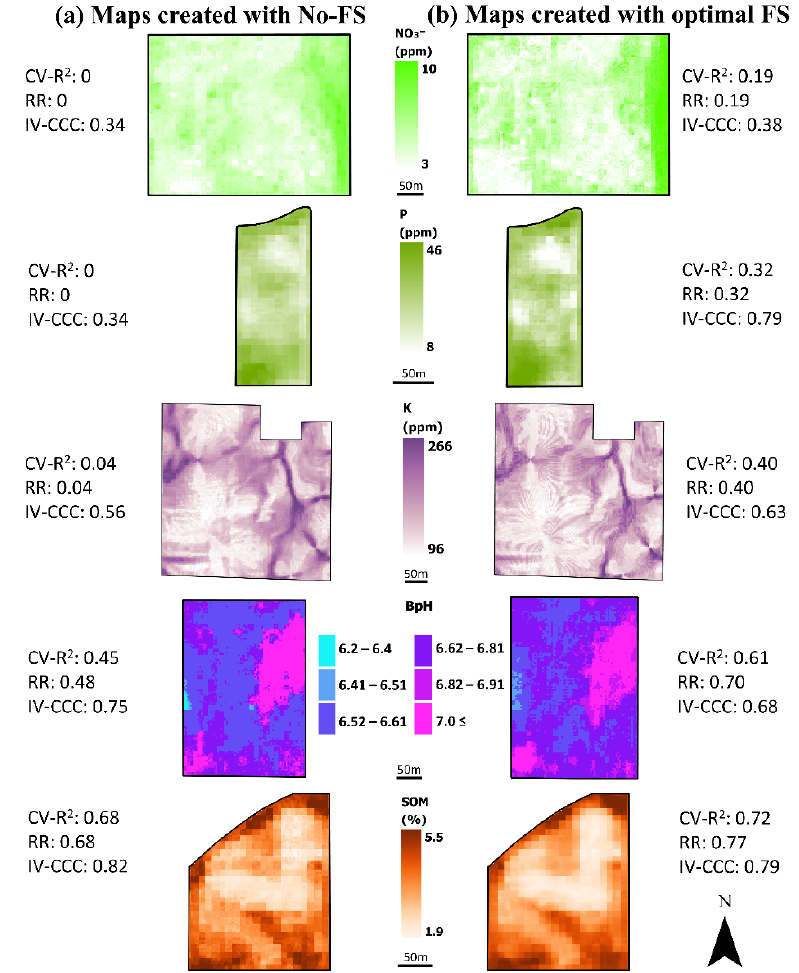
Figure 9. Examples of maps created by the optimal models built from covariate stacks with ( a ) No-FS and ( b ) FS. Applying FS generally led to less smooth maps compared to maps created with full covariate stacks. However, there were exceptions such as the SOM map shown in these examples. Maps shown reflect soil fertility levels present on the sampling dates: NO 3 − for field F (8 June 2019), P for field C (12 July 2019), K for field H (25 June 2018), BpH for field A (29 June 2020), and SOM for field D (16 July 2019).